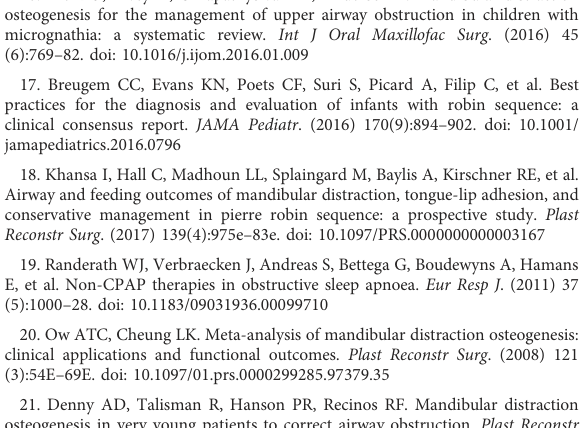
41. Figueroa AA, Polley JW, Friede H, Ko EW. Long-term skeletal stability after maxillary advancement with distraction osteogenesis using a rigid external distraction device in cleft maxillary deformities. Plast Reconstr Surg . (2004) 114 (6):1382 – 92. doi: